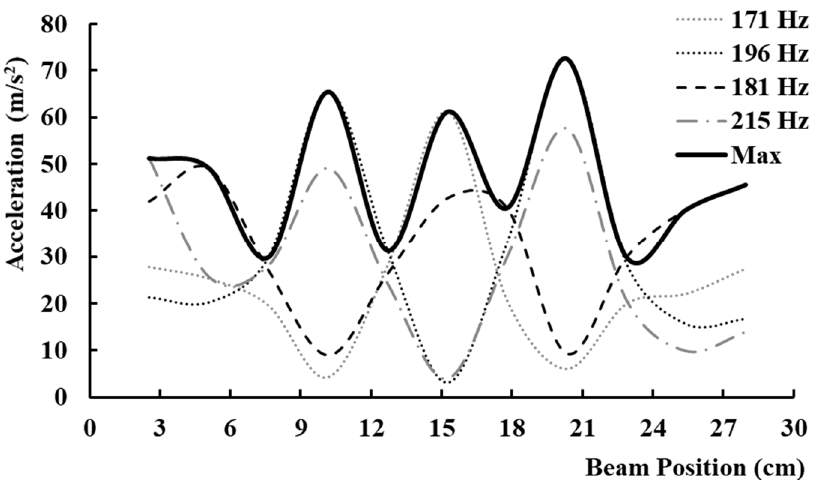
Figure 8. Experimentally measured maximum vibration potential of the freely positionable, fully controllable vibrotactile touch bar actuation system.